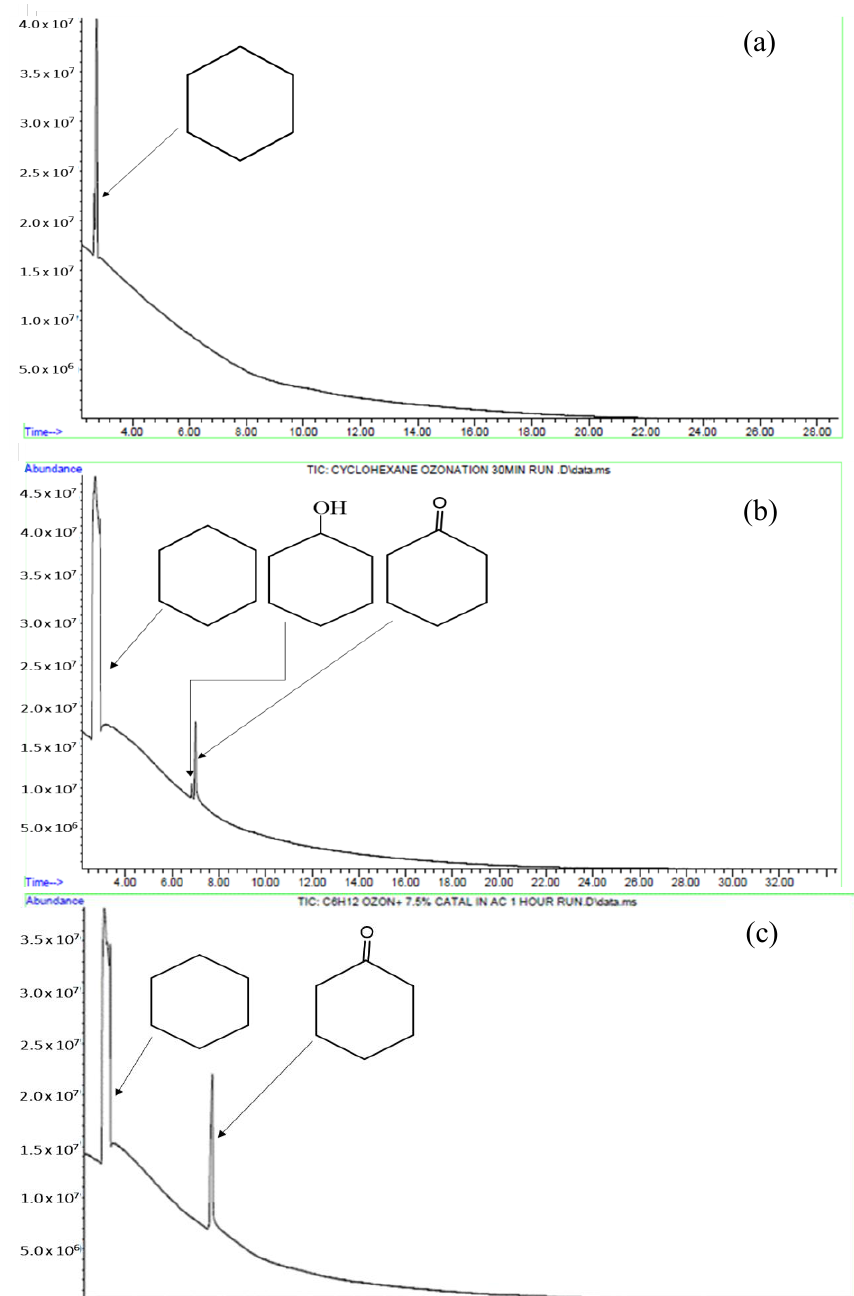
Figure 5. Gas chromatograms of the 2.5% Mn / γ -Al 2 O 3 catalysed cyclohexane oxidation mixtures ( a ) before ozonation, ( b ) after 30 min ozonation, and ( c ) after 1 h ozonation time at ambient conditions and pH = 3.